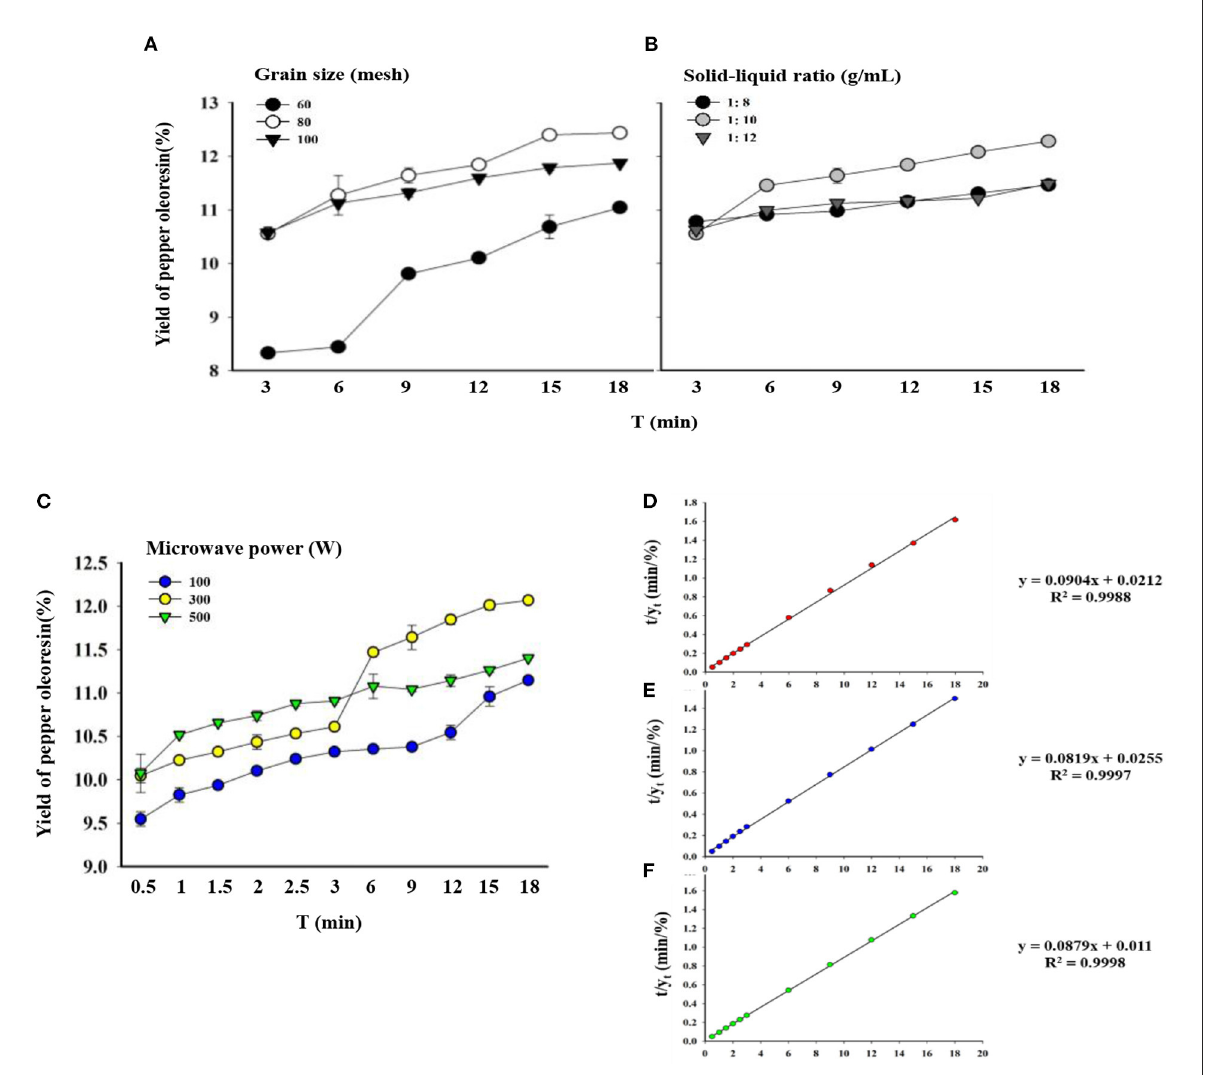
FIGURE4 Yields of pepper oleoresin under different extraction conditions and second-order extraction kinetics for different microwave powers. (A) Different particle sizes. (B) Different solid–liquid ratios. (C) Different microwave powers (solid–liquid ratio fixed at 1 g/10mL and particle size fixed at 80 mesh). (D) Second-order extraction kinetics of 100W. (E) Second-order extraction kinetics at 300W. (F) Second-order extraction kinetics at